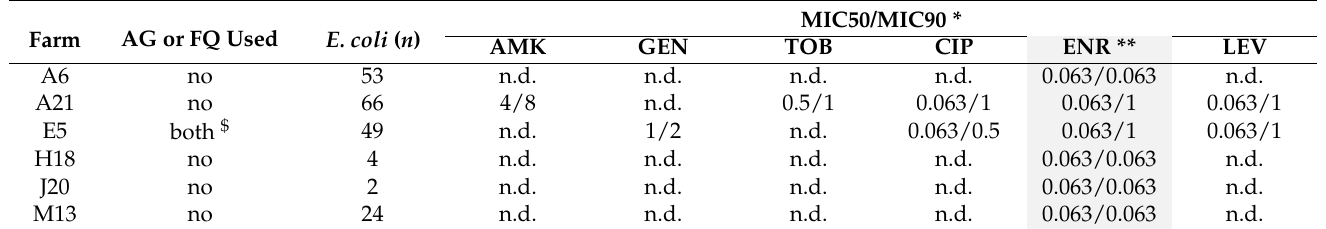
Table 12. Phenotypic susceptibility of meat-borne E. coli against-aminoglycosides (AG) and fluoro- quinolones